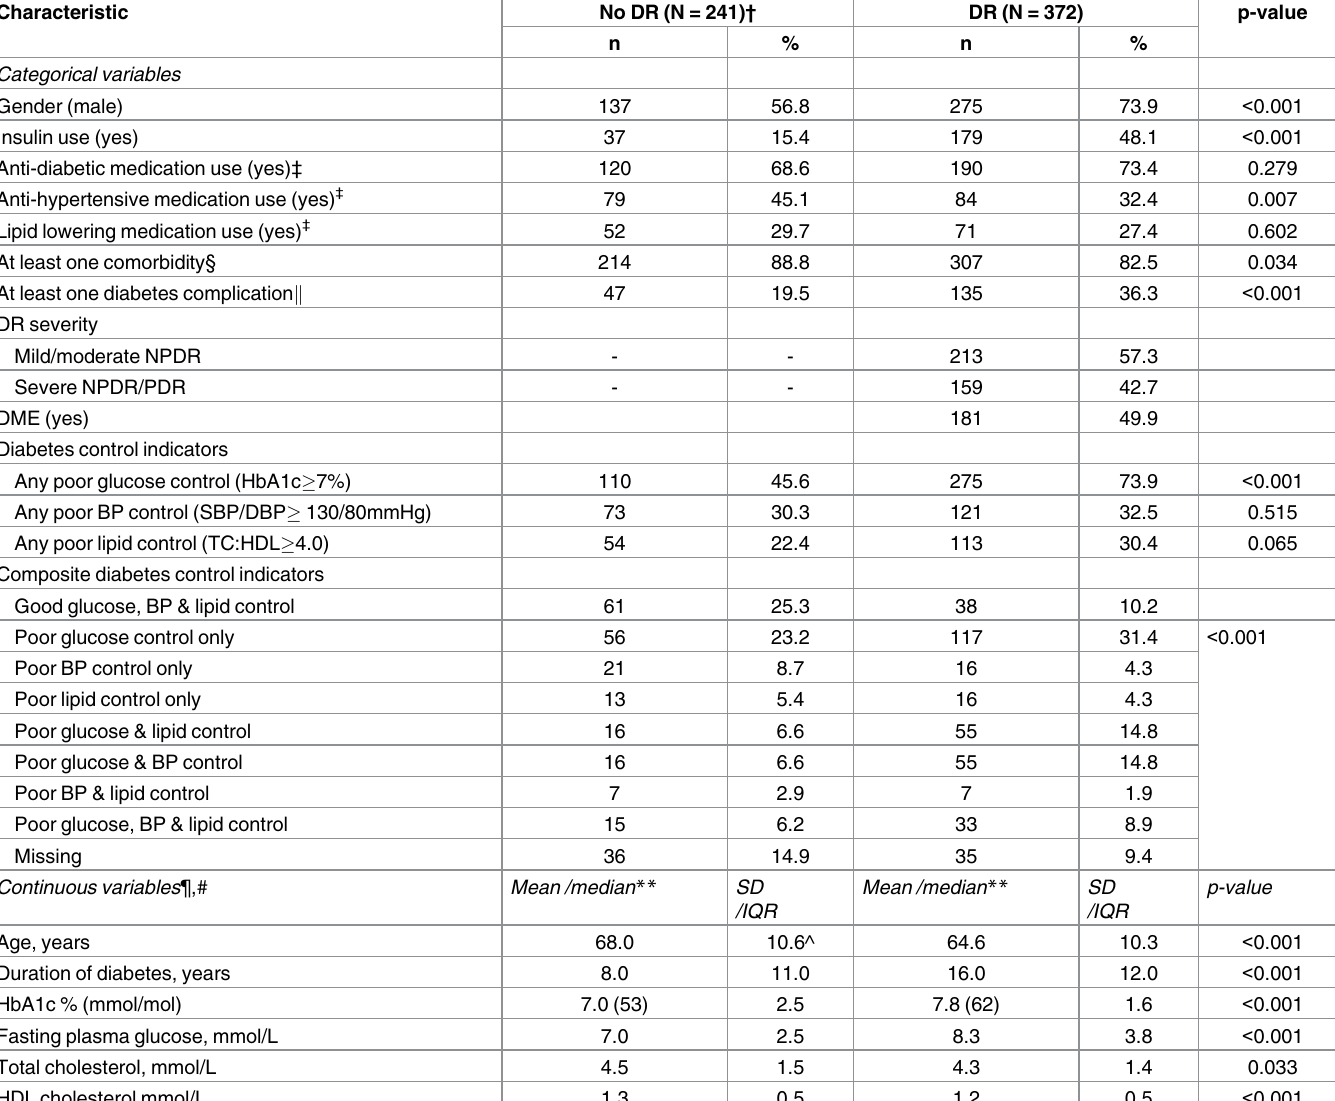
Table 1. Participants’ socio-demographic and clinical characteristics, stratified for no DR and DR * .